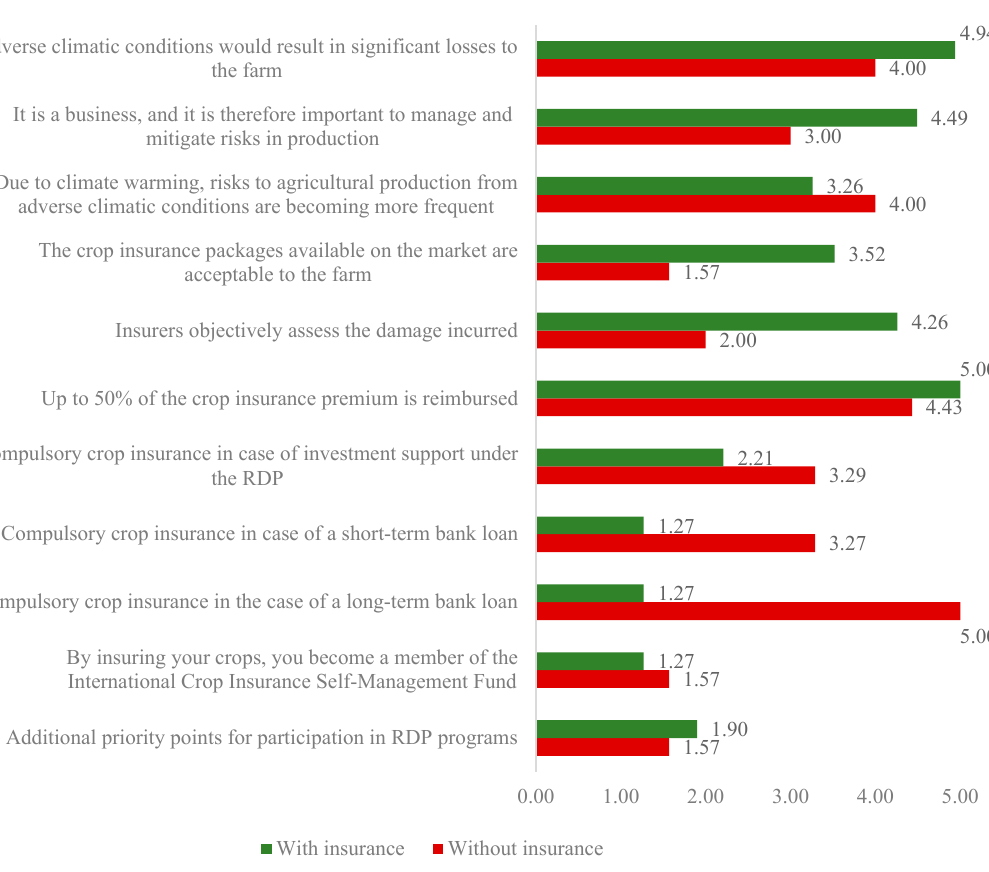
Figure 3. Reasons for farmers to take crop insurance.